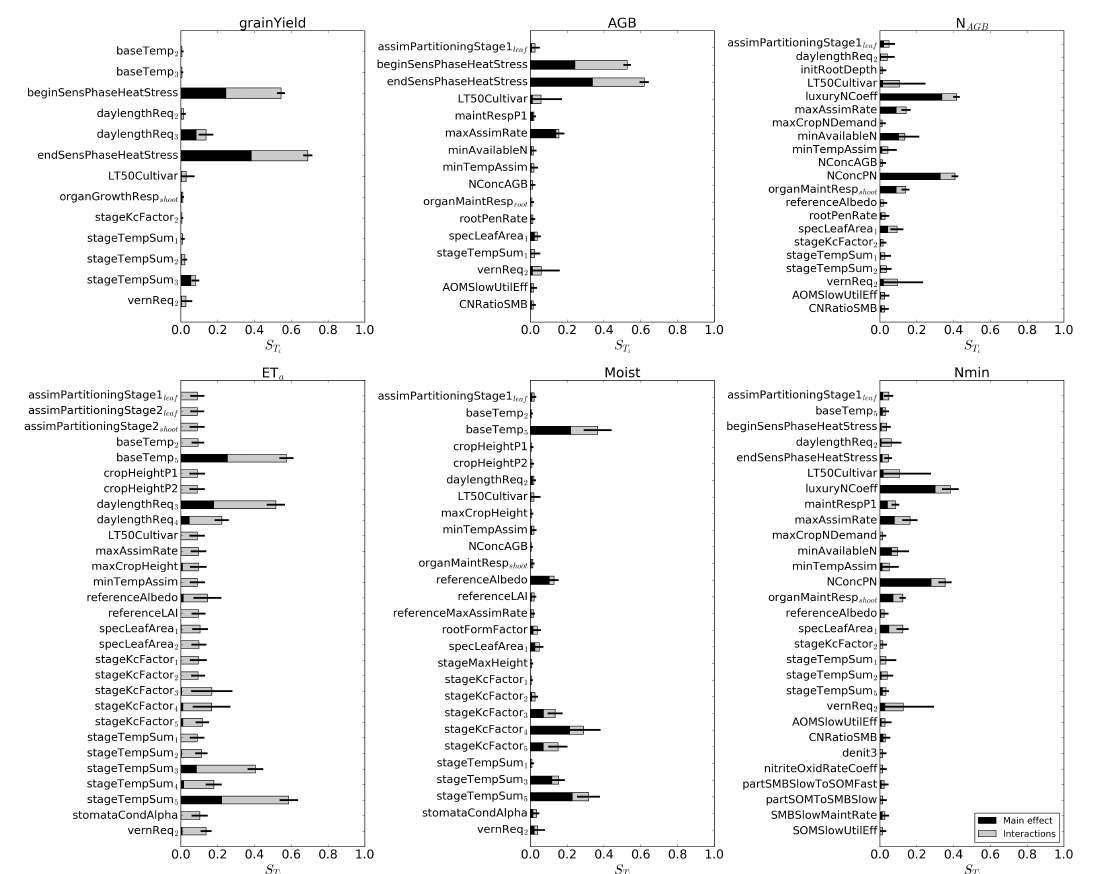
Figure 4. Total sensitivity indices for the most relevant model parameters calculated using the extended FAST approach averaged over all sites. The main effect denotes the portion of the total variance that is explained by the given parameter. The interactions represent the portion that is explained by all parameter interactions involving that parameter. The sum of the main effect and the interactions corresponds to the total sensitivity index ( S T ) of the i